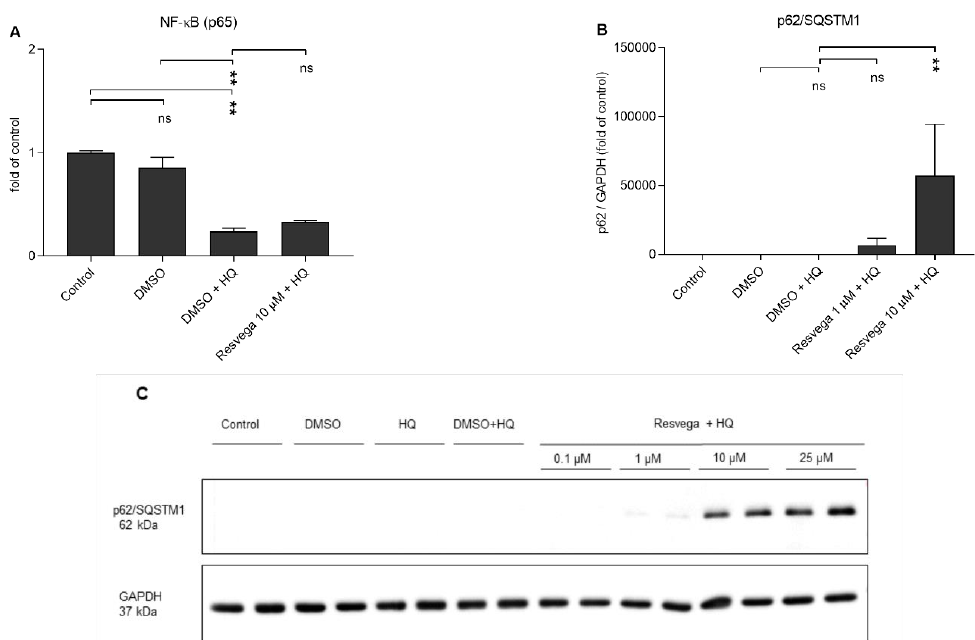
Figure 4. The e ff ect of hydroquinone (HQ 125 µ M) and Resvega (0.1–25 µ M; DMSO 0.5% v / v ) treatments on the activity of NF- κ B ( A ) and the amount of p62 / SQSTM1 protein ( B , C ). The levels of p62 / SQSTM1 protein were normalized to the internal protein control GAPDH ( B , C ). The values of untreated control cells were set to be 1 and other groups were compared to that. The results are combined from three independent experiments with two parallel samples per group in each experiment. Results are shown as mean ± SEM. ** p < 0.01, ns—not significant, Mann-Whitney U-test.